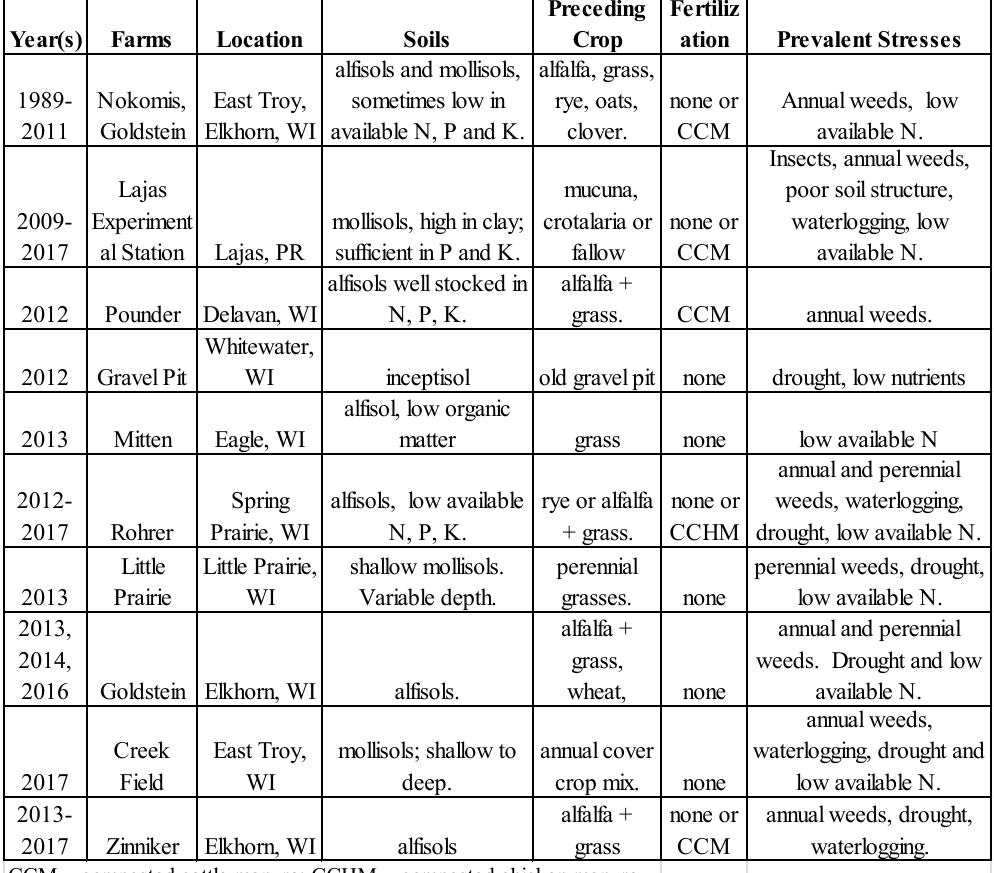
Table 1: Site information for nursery and yield trial sites used for breeding in Wisconsin or Puerto Rico Year(s) Farms Location Soils